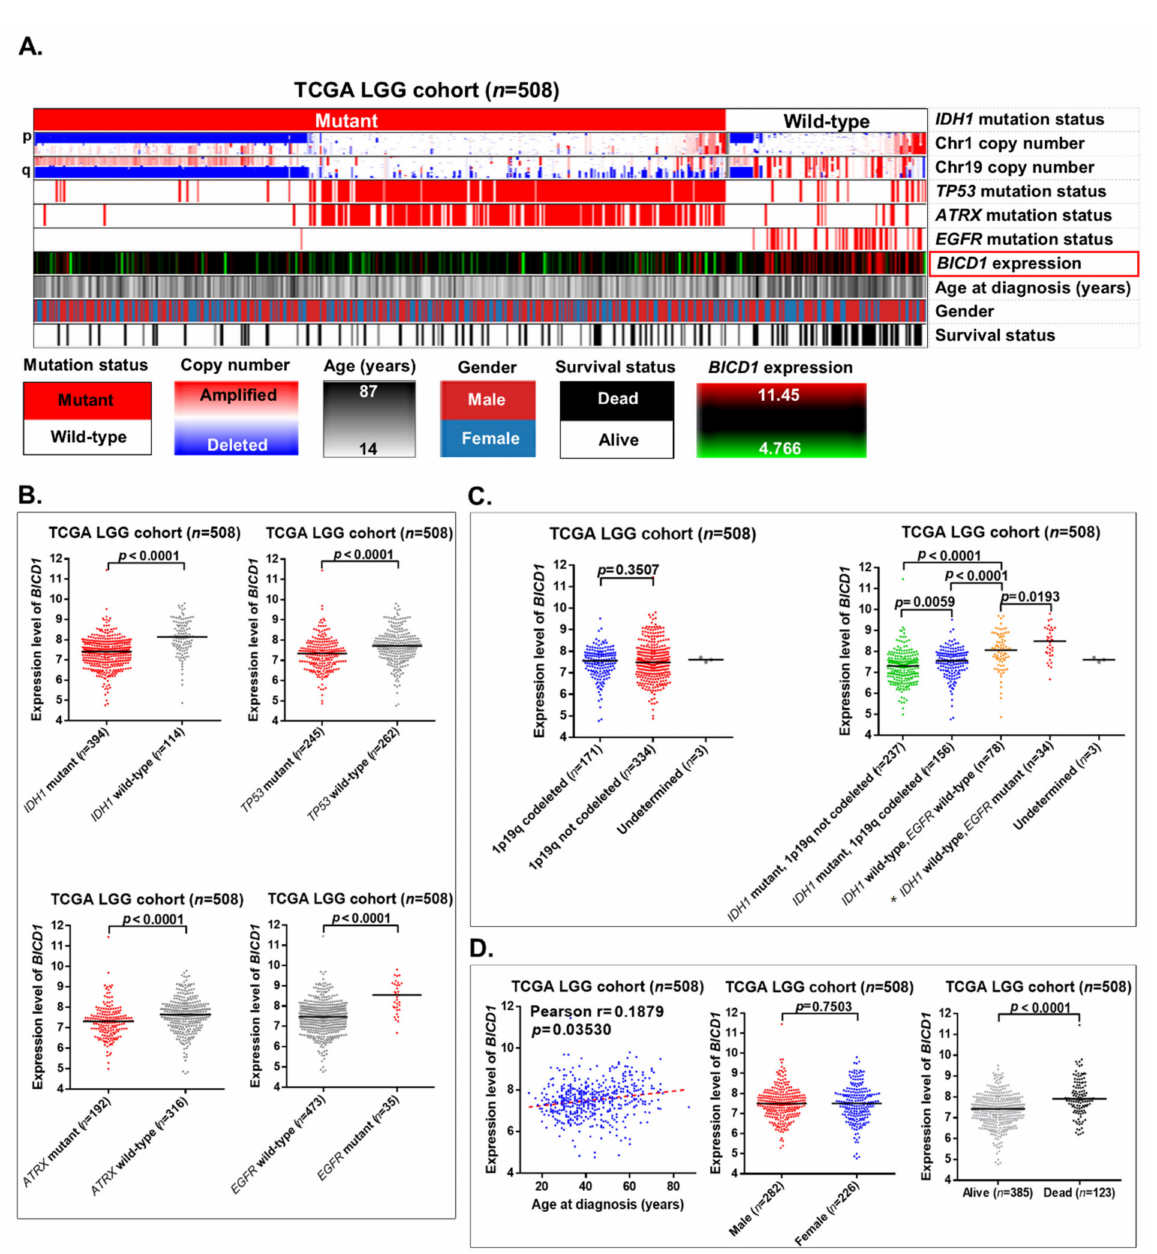
Figure 4. The correlations of BICD1 downregulation with chromosome 1p19q codeleted status, the mutation status of IDH1 , TP53 , ATRX, and EGFR , patient age, gender, and the survival status of LGG patients. ( A ). The heatmap revealed the correlations of BICD1 downregulation with 1p19q codeleted status, the mutation status of IDH1 , TP53 , ATRX, and EGFR , patient age, gender, and the survival status of patients in the TCGA LGG cohort. ( B ). The t -test analyses revealed the correlations between the expression levels of BICD1 and the mutation status of IDH1 , TP53 , ATRX, and EGFR . ( C ). The t -test analyses revealed the correlation between the expression levels of BICD1 and 1p19q codeleted status. The expression levels of BICD1 were also demonstrated in four subgroups of LGGs stratified according to their IDH1 status, 1p19q codeleted status, and EGFR status. * According to the 2016 WHO classification of CNS tumors, LGGs with wild-type IDH1 and mutant EGFR could be considered to be glioblastoma (grade IV glioma) rather than LGGs (grade II and III gliomas). ( D ). The t -test and Pearson’s correlation analyses revealed the correlations of BICD1 expression with patient age, gender, and their survival